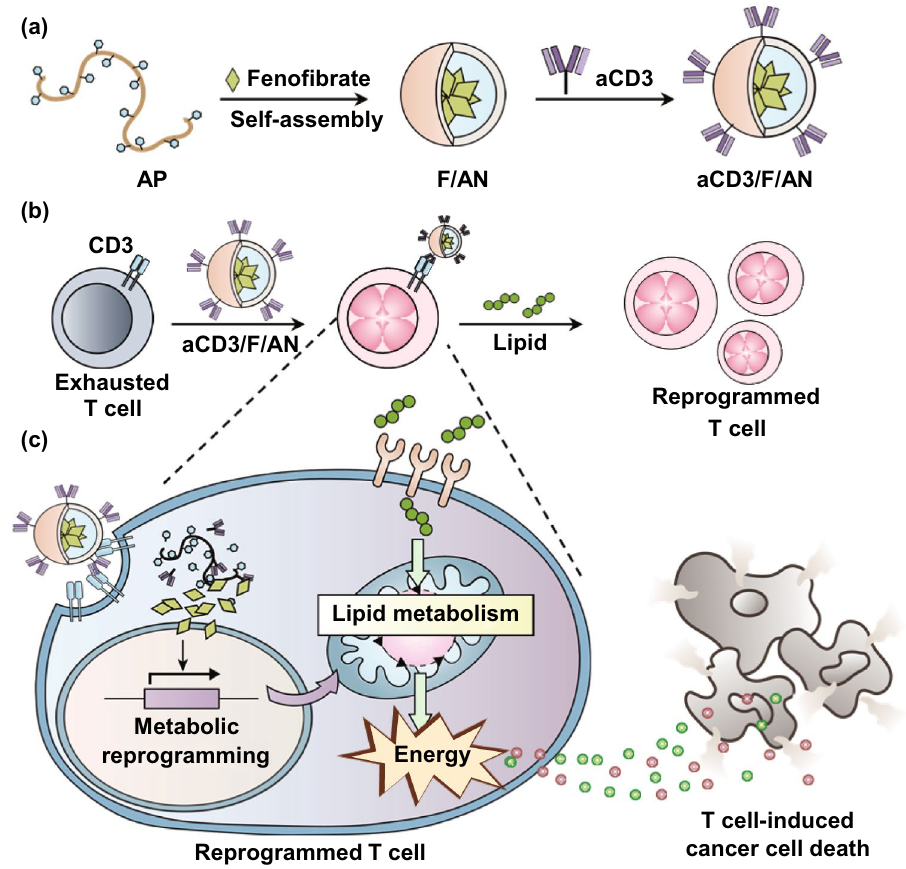
Fig. 1 Metabolic reprogramming of T cells by aCD3/F/ANs. a Schematic illustration of the aCD3/F/AN preparation process. b Mechanism by which aCD3/F/ANs increase mitochondrial fatty acid metabolism in T cells. c Proposed effect of fatty acid metabolism reprogramming on T cell‑mediated killing of cancer